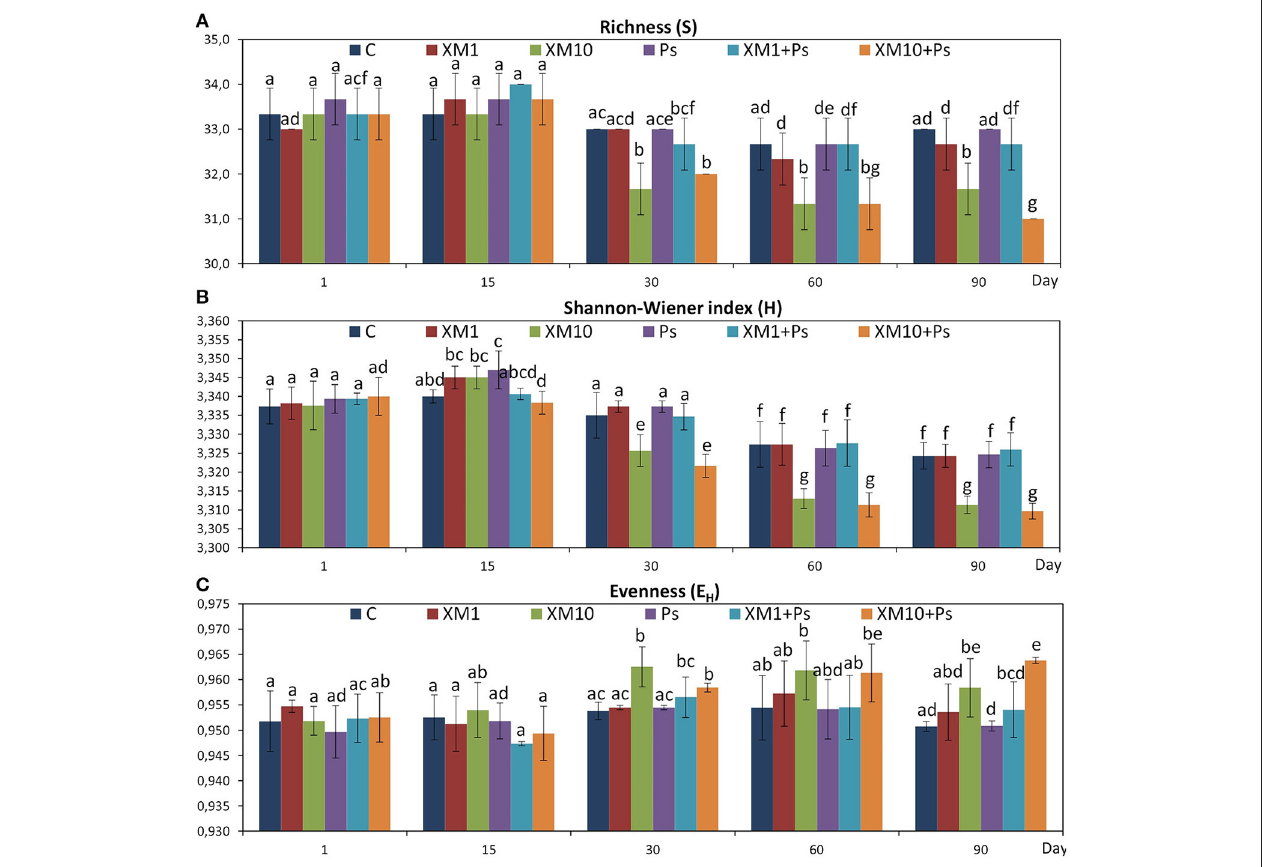
FIGURE 5 | Values of the richness (A) , Shannon-Wiener (B) , and evenness (C) indices for the cefuroxime (XM)- and/or Pseudomonas putida MC1 (Ps)-treated soils obtained during the experimental period. The data are the means ( n = 3) with standard deviations. Different letters within the values of each index indicate significant differences considering the effects of the dose of XM, strain MC1 and incubation time (LSD post-hoc test; P < 0.05). The explanation of the treatment abbreviations is given in Figure 4 .